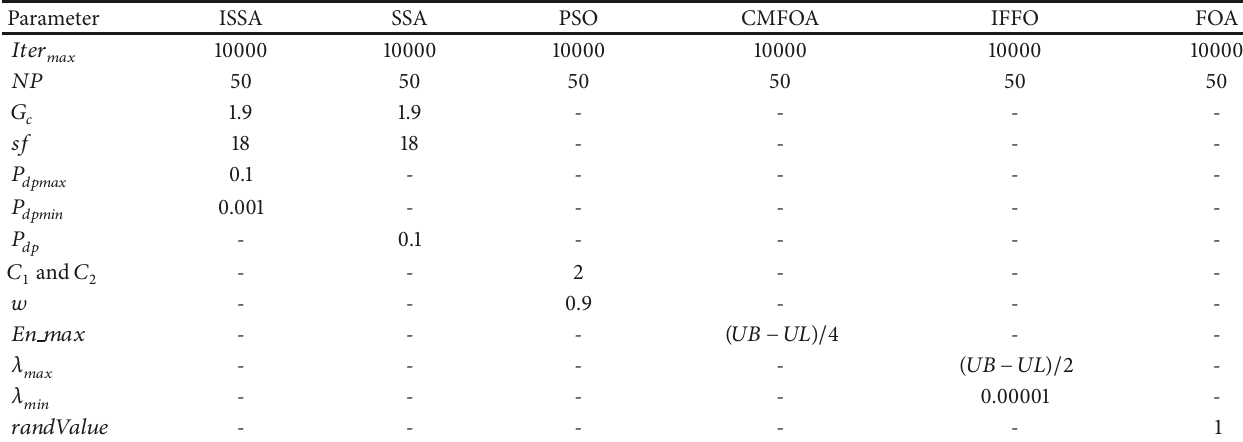
Table 1: Parametric settings of algorithms.